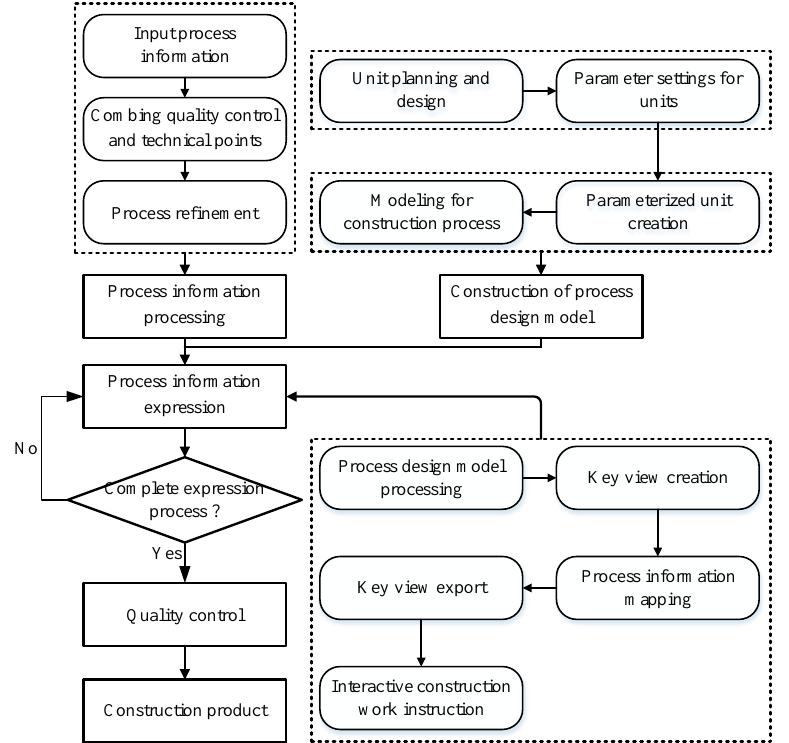
Figure 1. Digital expression method of technological process.